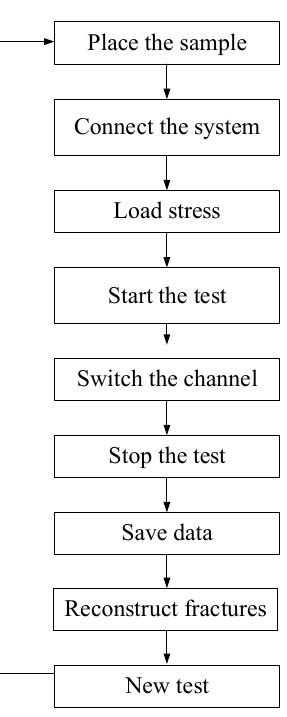
Figure 5. Flowchart of the experimental step.